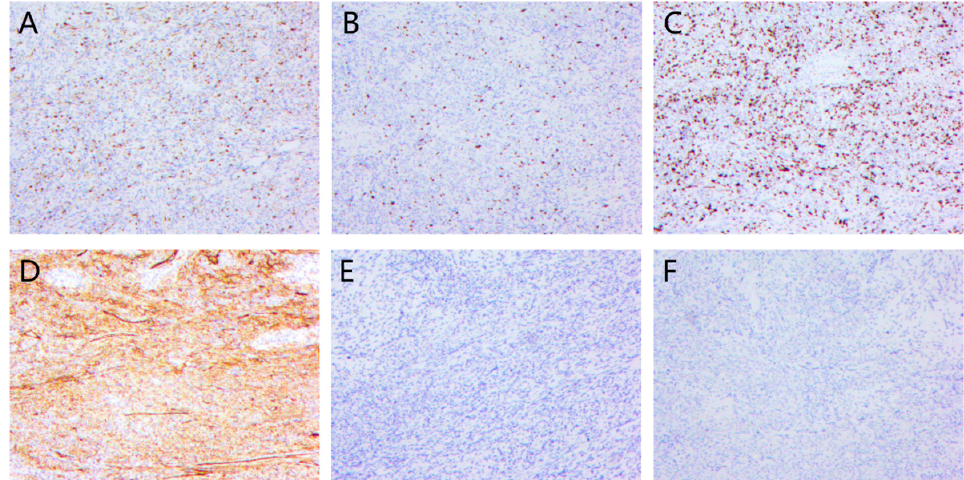
Figure 6. Immunohistochemical appearance MPNST. ( A ) S100 protein-positive cells are largely reduced in MPNST. ( B ) SOX-10 protein-positive cells are fewer than S100. ( C ) Ki-67 labeling index is elevated to >10%. ( D ) CD34-positive fibroblastic lattice is reduced. ( E ) Desmin stain is negative. ( F ) H3K27me3 is completely loss in MPNST.